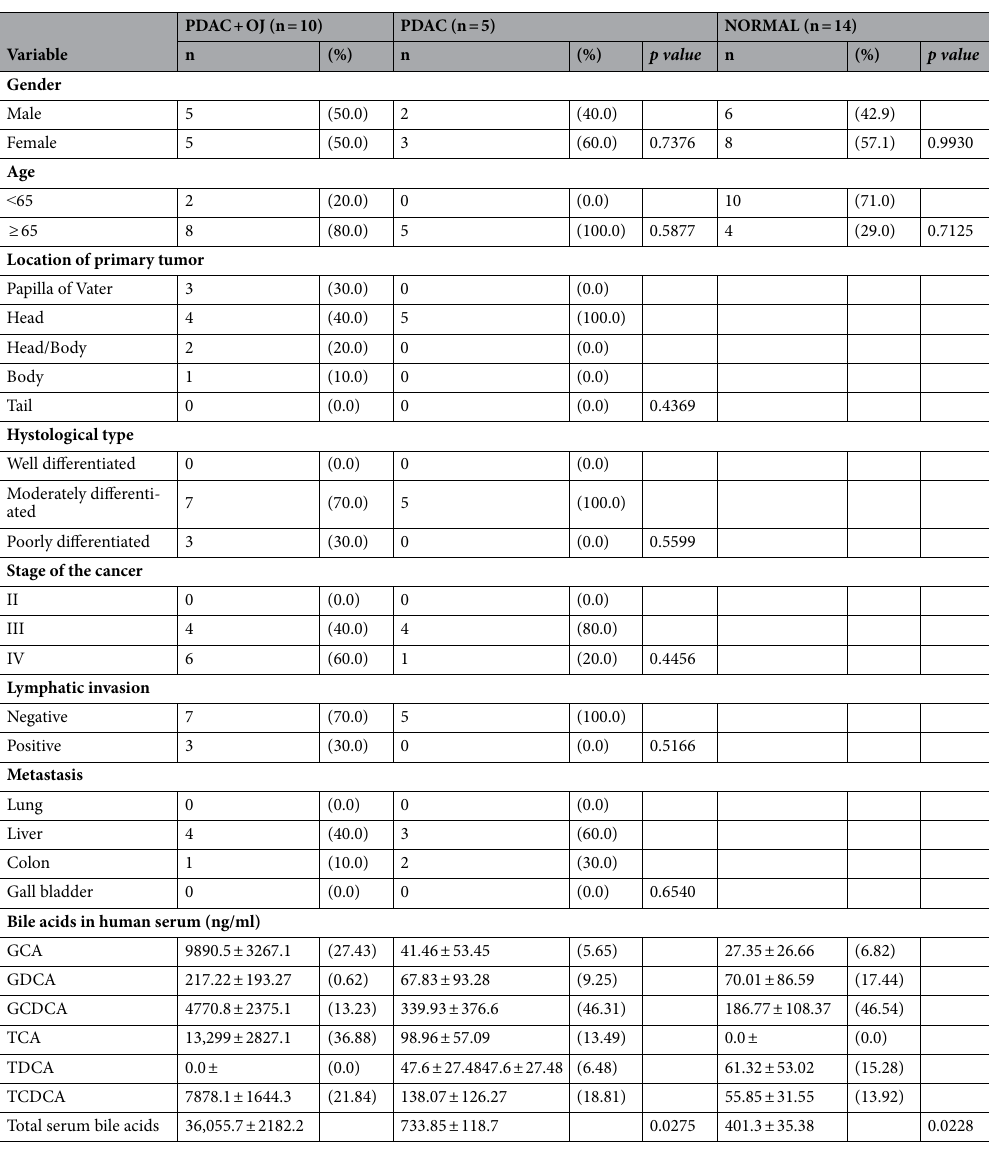
Table 1. Clinicopathological characteristics of pancreatic cancer patients selected for serum bile acid